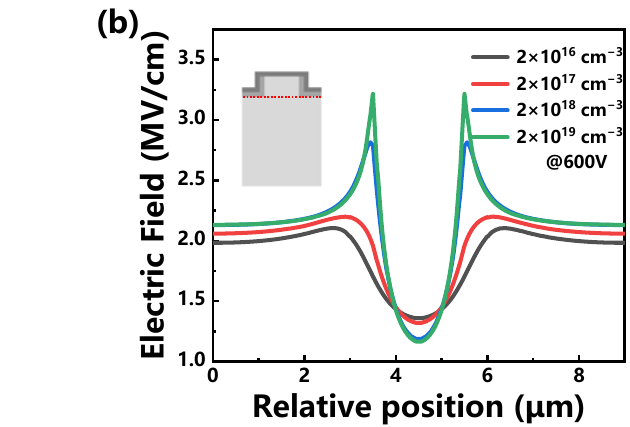
Figure 3. ( a ) Breakdown voltage as a function of p-doping concentration for TJBS diodes with different drift layer concentrations; and ( b ) electric field profiles along the bottom of p-GaN for TJBS diodes with different p-doping concentrations at the reverse bias of 600 V when the drift layer concentration is 2 × 10 16 cm − 3 .